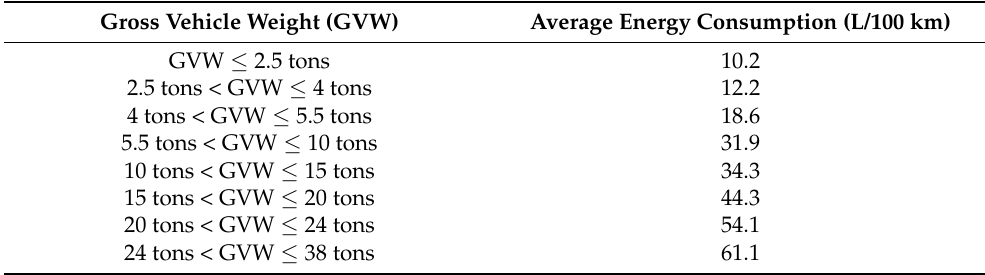
Table 4. Average energy consumption based on gross vehicle weight. Gross Vehicle Weight (GVW) Average Energy Consumption (L/100